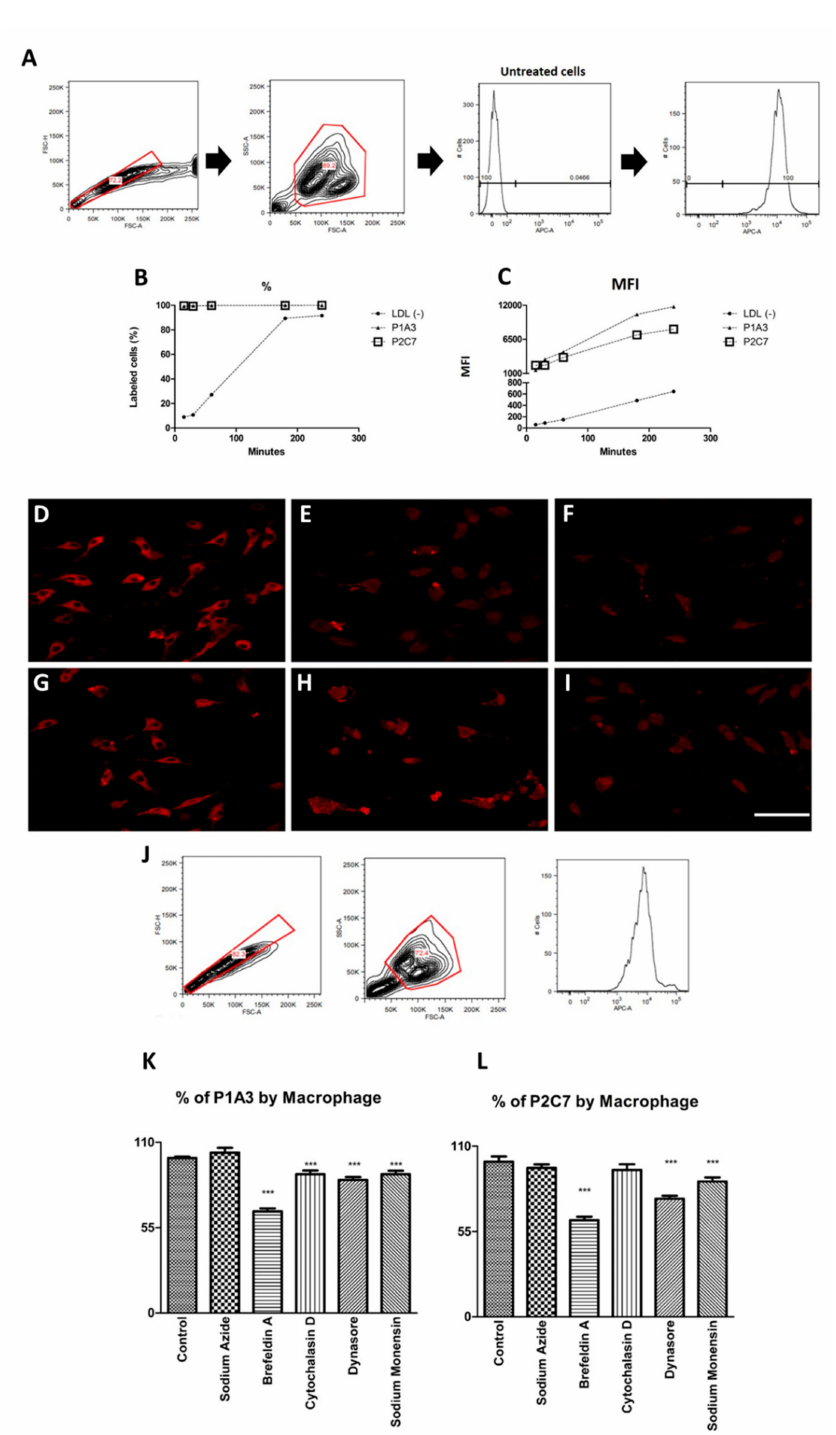
Figure 3. P1A3 and P2C7 internalization by macrophages. ( A – C ): Bone marrow-derived macrophages were incubated with 100 µ g / mL of Cy5-P1A3, Cy5-P2C7, and Dil-LDL ( − ) and the cells were analysed by flow cytometry ( A ) at 15, 30, 60, 180, and 240 min. The percentage of labeled cells was